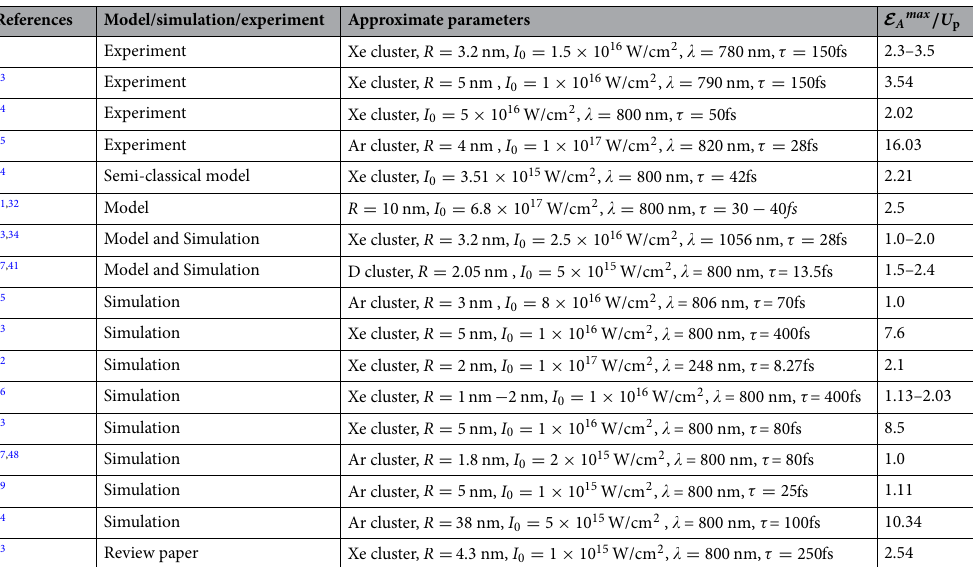
Amax (in units of ponderomotive energy Amax remains close to 3.2 U p or